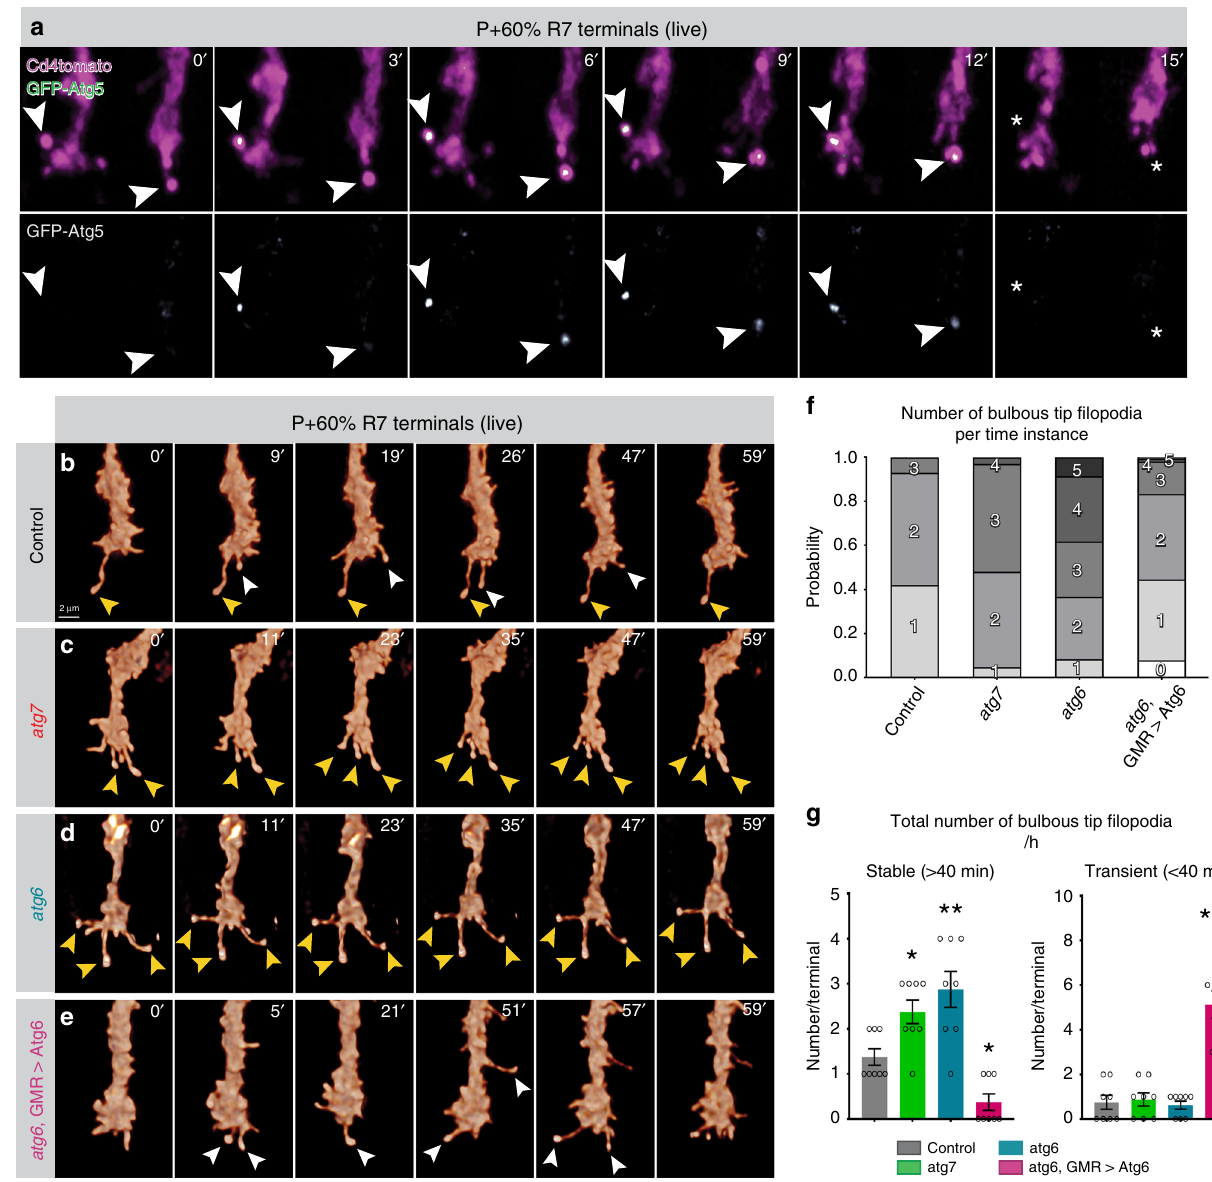
Fig. 5 Autophagy regulates the stability of synaptogenic fi lopodia at axon terminals. a Live imaging of GFP-Atg5-expressing R7 axon terminals in intact, developing Drosophila brain shows formation of autophagosomes at the bulbous tips of synaptogenic fi lopodia 14 followed by the collapse of fi lopodia (P + 60%). Repeated three times independently with similar results. b – e Live imaging of R7 axon terminals at P + 60% (during synaptogenesis) revealed increased stability of synaptogenic fi lopodia in autophagy-de fi cient R7 terminals ( c , d ) and decreased stability in R7 terminals with upregulated autophagy ( e ) compared with control ( b ). Yellow arrowheads: stable synaptogenic fi lopodia; white arrowheads: unstable bulbous tip fi lopodia. Repeated fi ve to ten times independently with similar results. f Number of concurrently existing bulbous tip fi lopodia per R7 axon terminal per time instance. g Total number of synaptogenic fi lopodia per R7 axon terminal per hour. Autophagy-de fi cient R7 terminals exhibit signi fi cantly more stable synaptogenic fi lopodia (>40 min), whereas upregulated autophagy leads to fi lopodia destabilization. n = 8 terminals per condition. One-way ANOVA and Tukey ’ s HSD as post-hoc test; * p < 0.05, ** p < 0.01, *** p < 0.001. Error bars denote mean ± SEM. Source data are provided as a Source Data fi